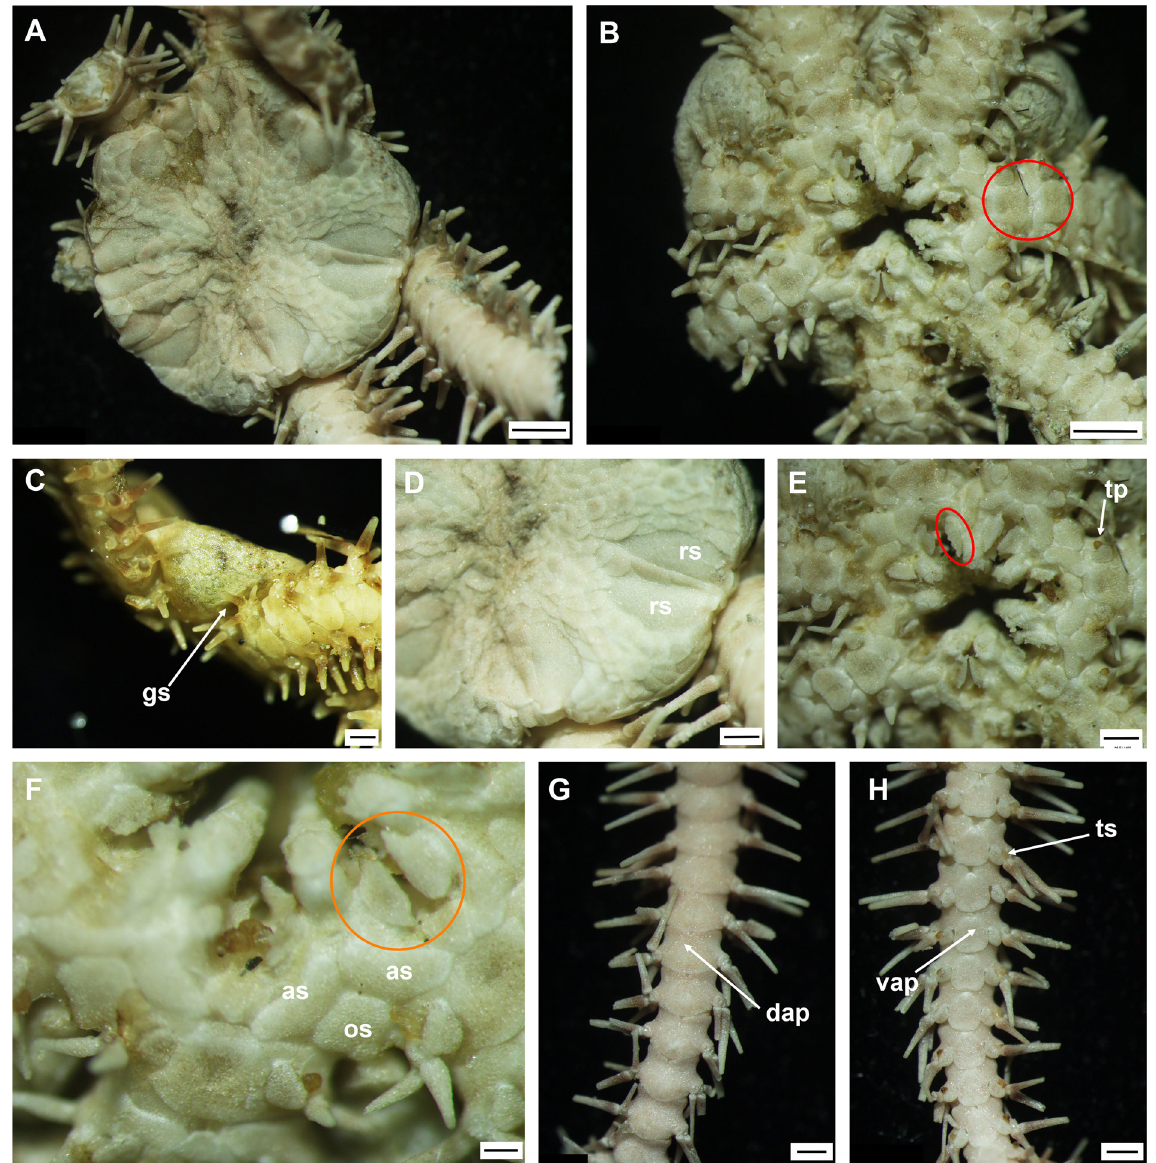
Fig. 40. Ophiactis cf. brachygenys H.L. Clark, 1911 (IDSSE EEB-SW0015 = heptamerous specimen). A . Dorsal disc. B . Ventral disc (first and second ventral arm plates highlighted). C . Lateral disc. D . Radial shields. E–F . Oral frame (operculiform lateral oral papillae highlighted). G . Dorsal arm. H . Ventral arm. Abbreviations: as = adoral shield; dap = dorsal arm plate; gs = genital slit; os = oral shield; rs = radial shield; tp = tentacle pore; ts = tentacle scale; vap = ventral arm plate. Scale bars: A–B = 1 mm; C–E, G–H = 500 µm; F = 200